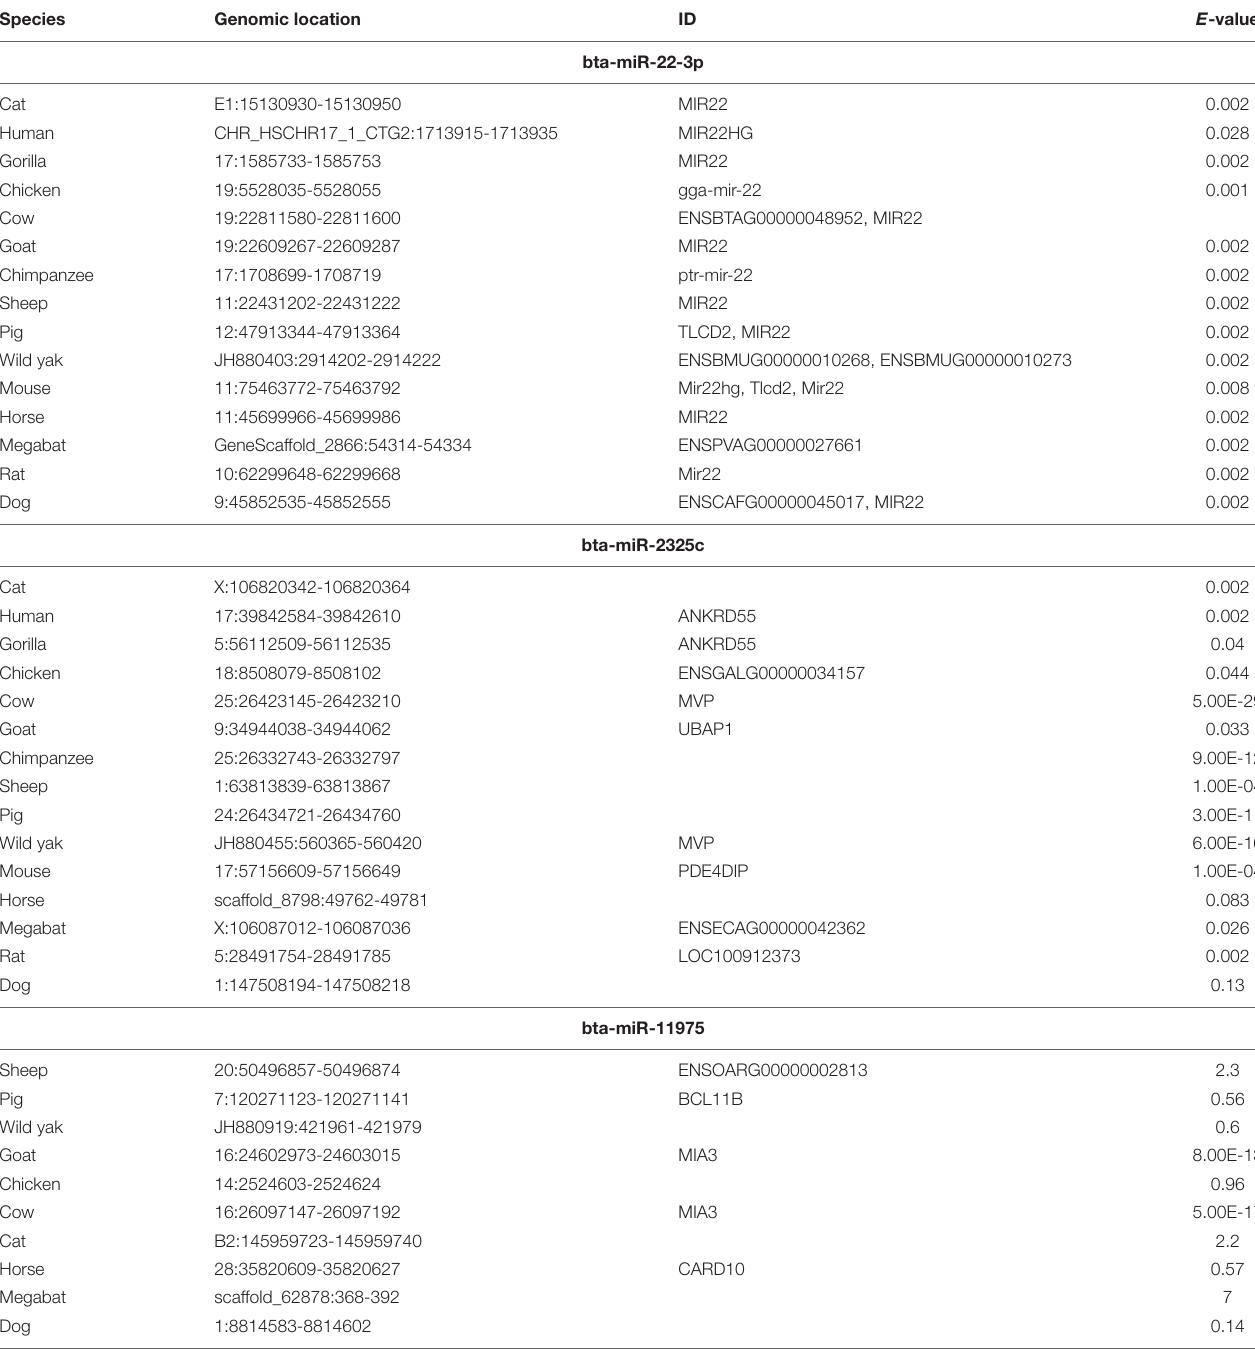
TABLE 3 | Characteristics of sequences used to create the phylogenies for bta-miR-22-3p, bta-miR-2325c, and bta-miR-11975.